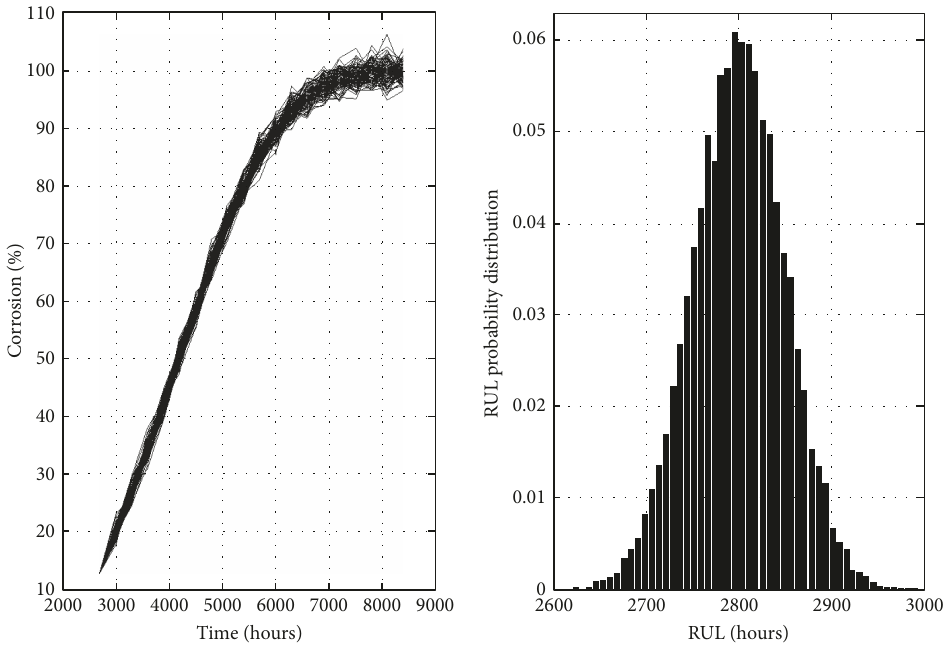
Figure 5: The RUL probability mass function and the damage trajectory